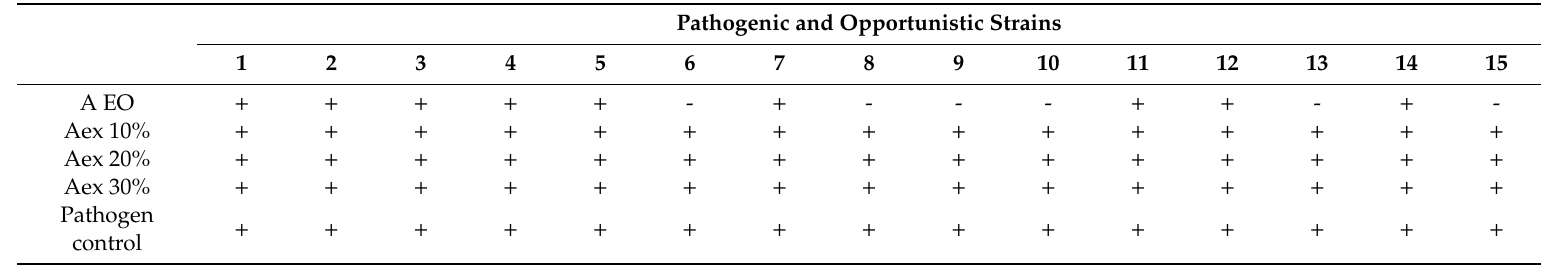
Table 2. Antimicrobial activities of the Artemisia absinthium EO (concentration 0.1%) and Artemisia absinthium water extract (concentrations 10%, 20%, 30%) against pathogenic opportunistic microorganisms in liquid medium ( + indicated pathogen growth; − indicated that pathogen growth was not